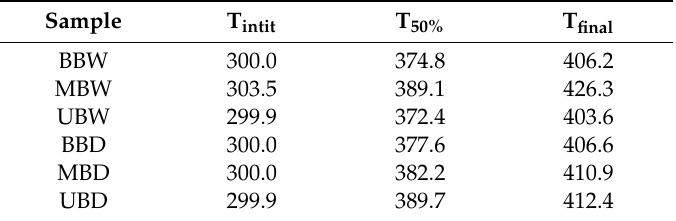
Figure 10. Representative TG curves of the analyzed samples. Table 5. Characteristic temperatures (average values) of main stage thermal degradation of the analyzed